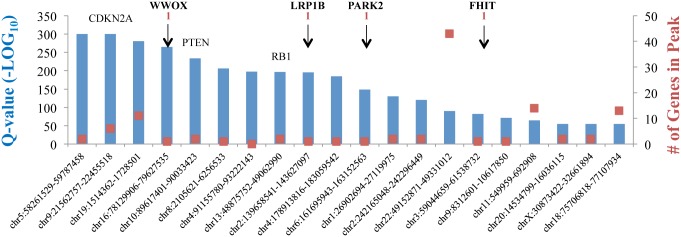
Most frequently deleted genomic loci in 8,822 epithelial cancer samples from 25 cancer types.Data contains copy number data from non-TCGA projects [14] and data generated by the Broad Institute TCGA Genome Characterization Center of the GISTIC portal. The blue bars (left y-axis) are Q-values (–Log10), representing that the gene inside the locus significantly enriched for deletion because of selective pressures. Highly deleted genes imply their role as tumor suppressors. The red dots (right y-axis) are the number of genes inside the peak. Numbers under CFS genes emphasize that these are unique within their peak.